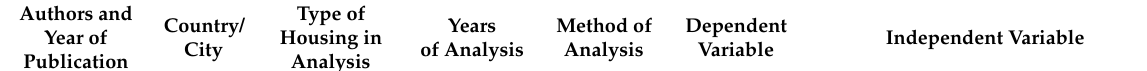
Table A1. Overview of the research literature on new housing